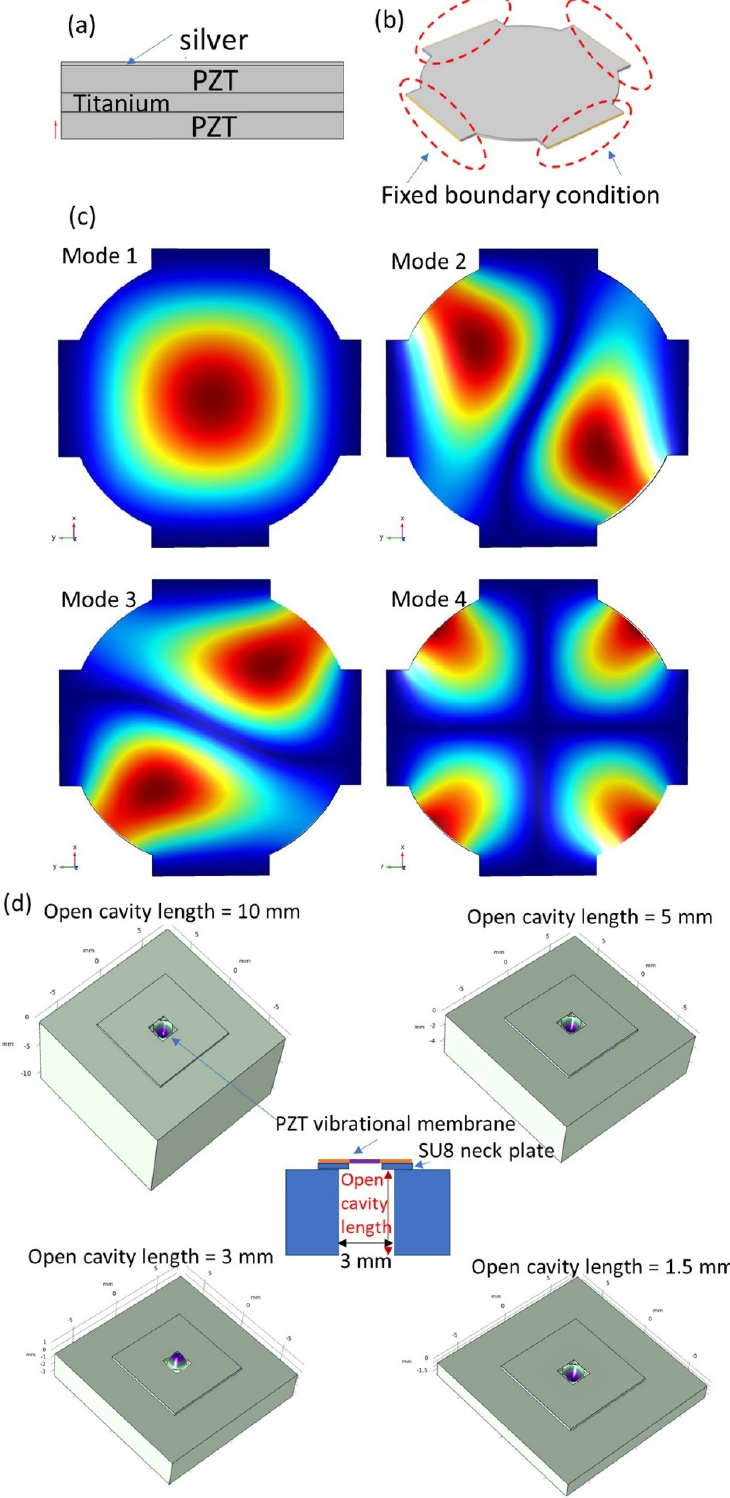
Figure 2. The results of COMSOL simulation. ( a ) Four layers of the PMUT film. ( b ) Boundary condition setting. ( c ) The mode shapes of the 1st, 2nd, 3rd, and 4th resonances. ( d ) The open-cavity cases with different cavity lengths.